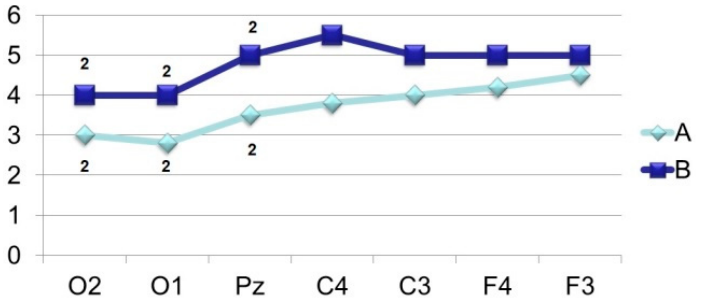
Figure 7. Averaged values of amplitudes and factor characteristics of amplitudes and PL of the N 450 ERP component. Note. Legend in Figure